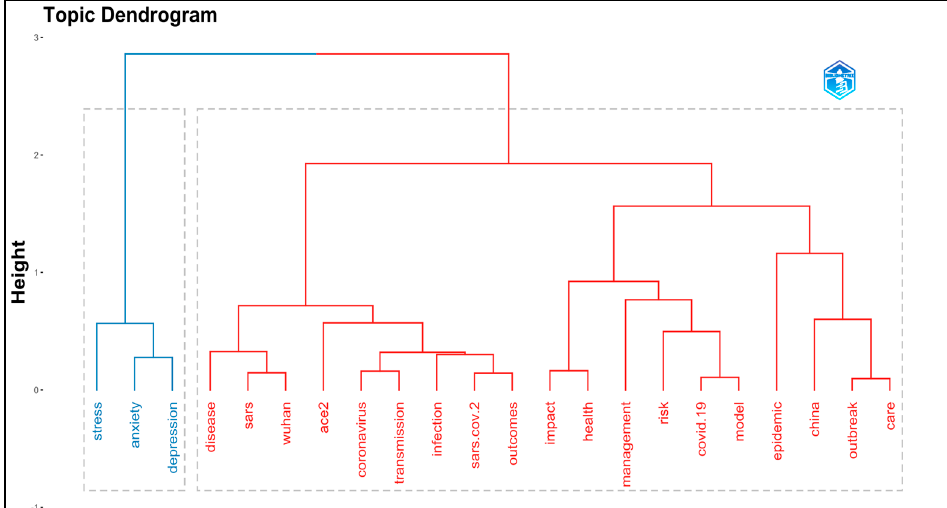
Figure 3. Topic dendrogram based on KeyWords Plus.